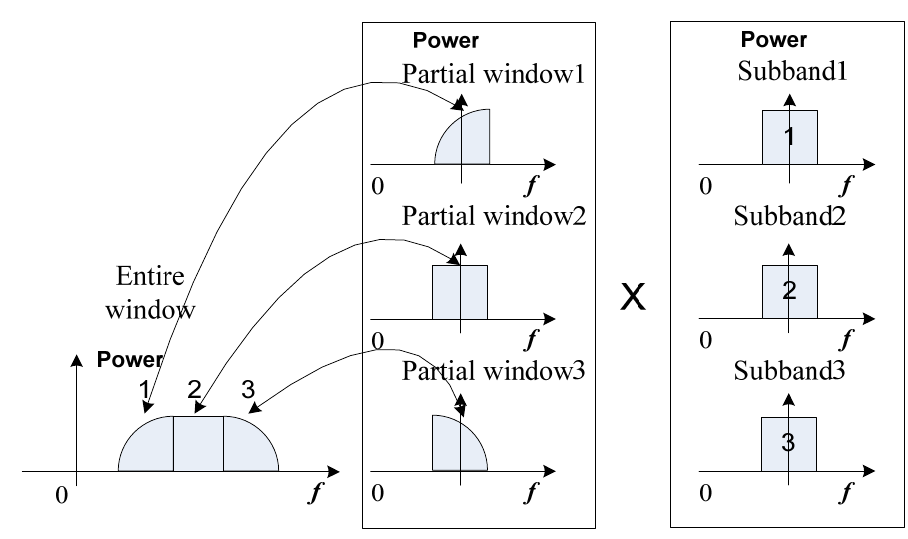
Figure 3. The partial